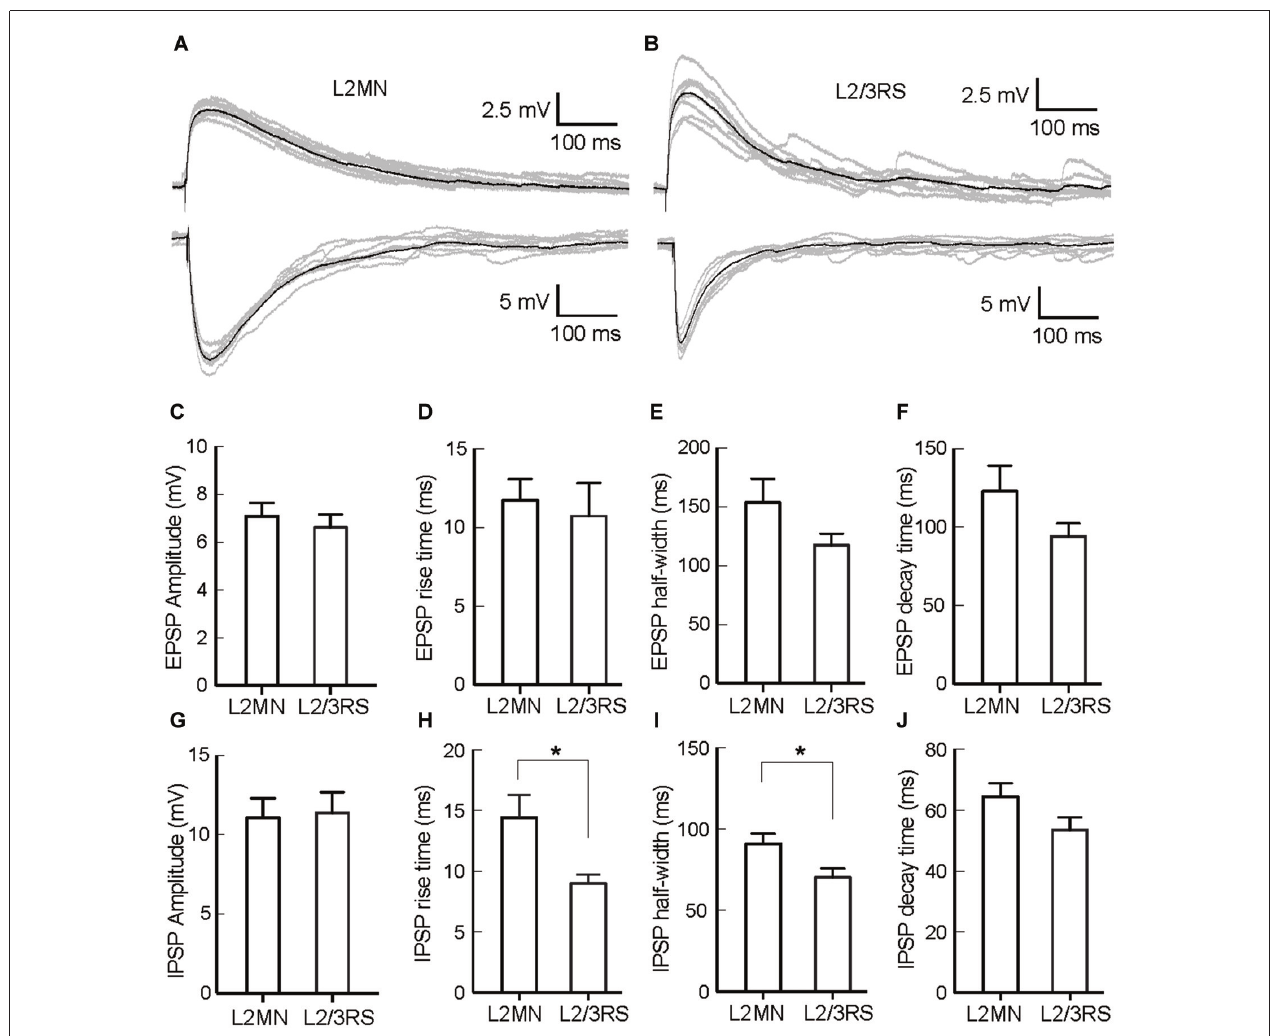
FIGURE 5 | Comparison of synaptic responses evoked by stimulation of L1 in L2MNs and L2/3RS neurons. (A,B) Examples of EPSPs (Top) and IPSPs (Bottom) in a L2MN (A) and a L2/3RS neuron (B) . Gray traces are eight consecutive recordings, and the black traces are the average of the gray traces. (C–F) Comparisons of the amplitude, rise time, half-width and decay time, respectively, of EPSPs. Error bar = SEM. (G–J) Comparisons of the amplitude, rise time, half-width and decay time, respectively, of IPSPs. Error bar = SEM; ∗ p < 0.05.